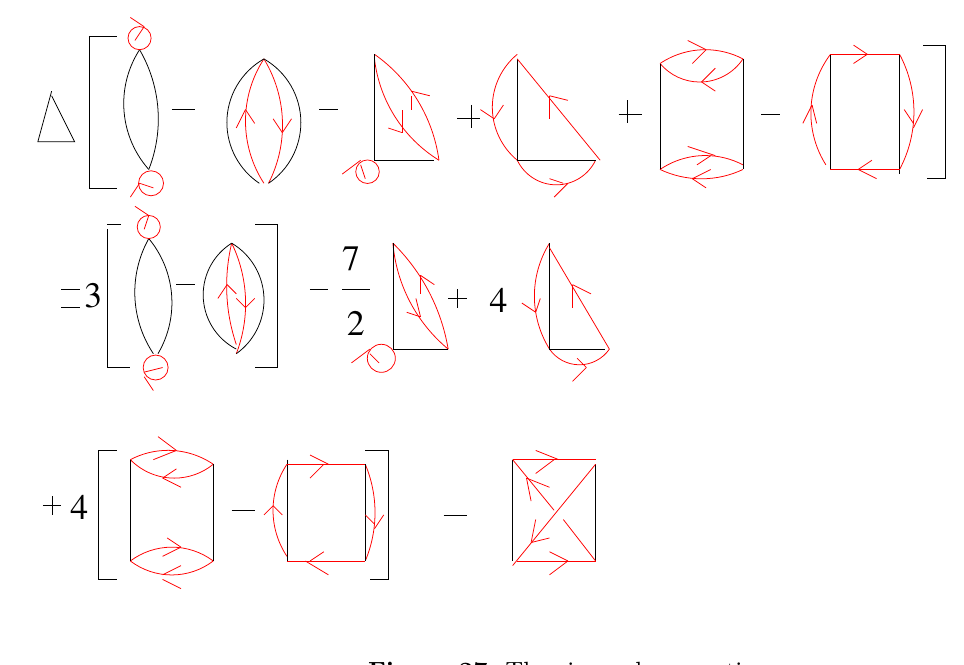
Figure 27 . The eigenvalue